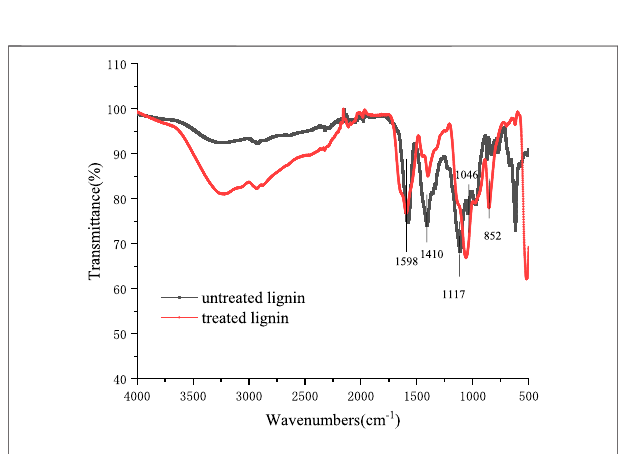
FIGURE 5 | SEM images on lignin treated with Bacillus subtilis TR-03. (A) untreated lignin; (B) lignin treated for 5 days with Bacillus subtilis TR-03.